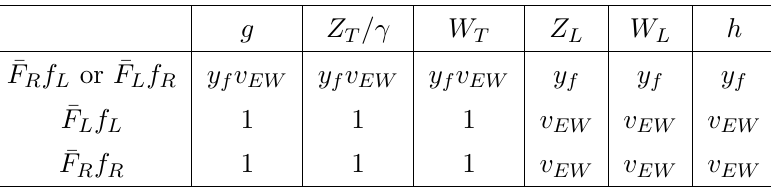
1 correspond to /